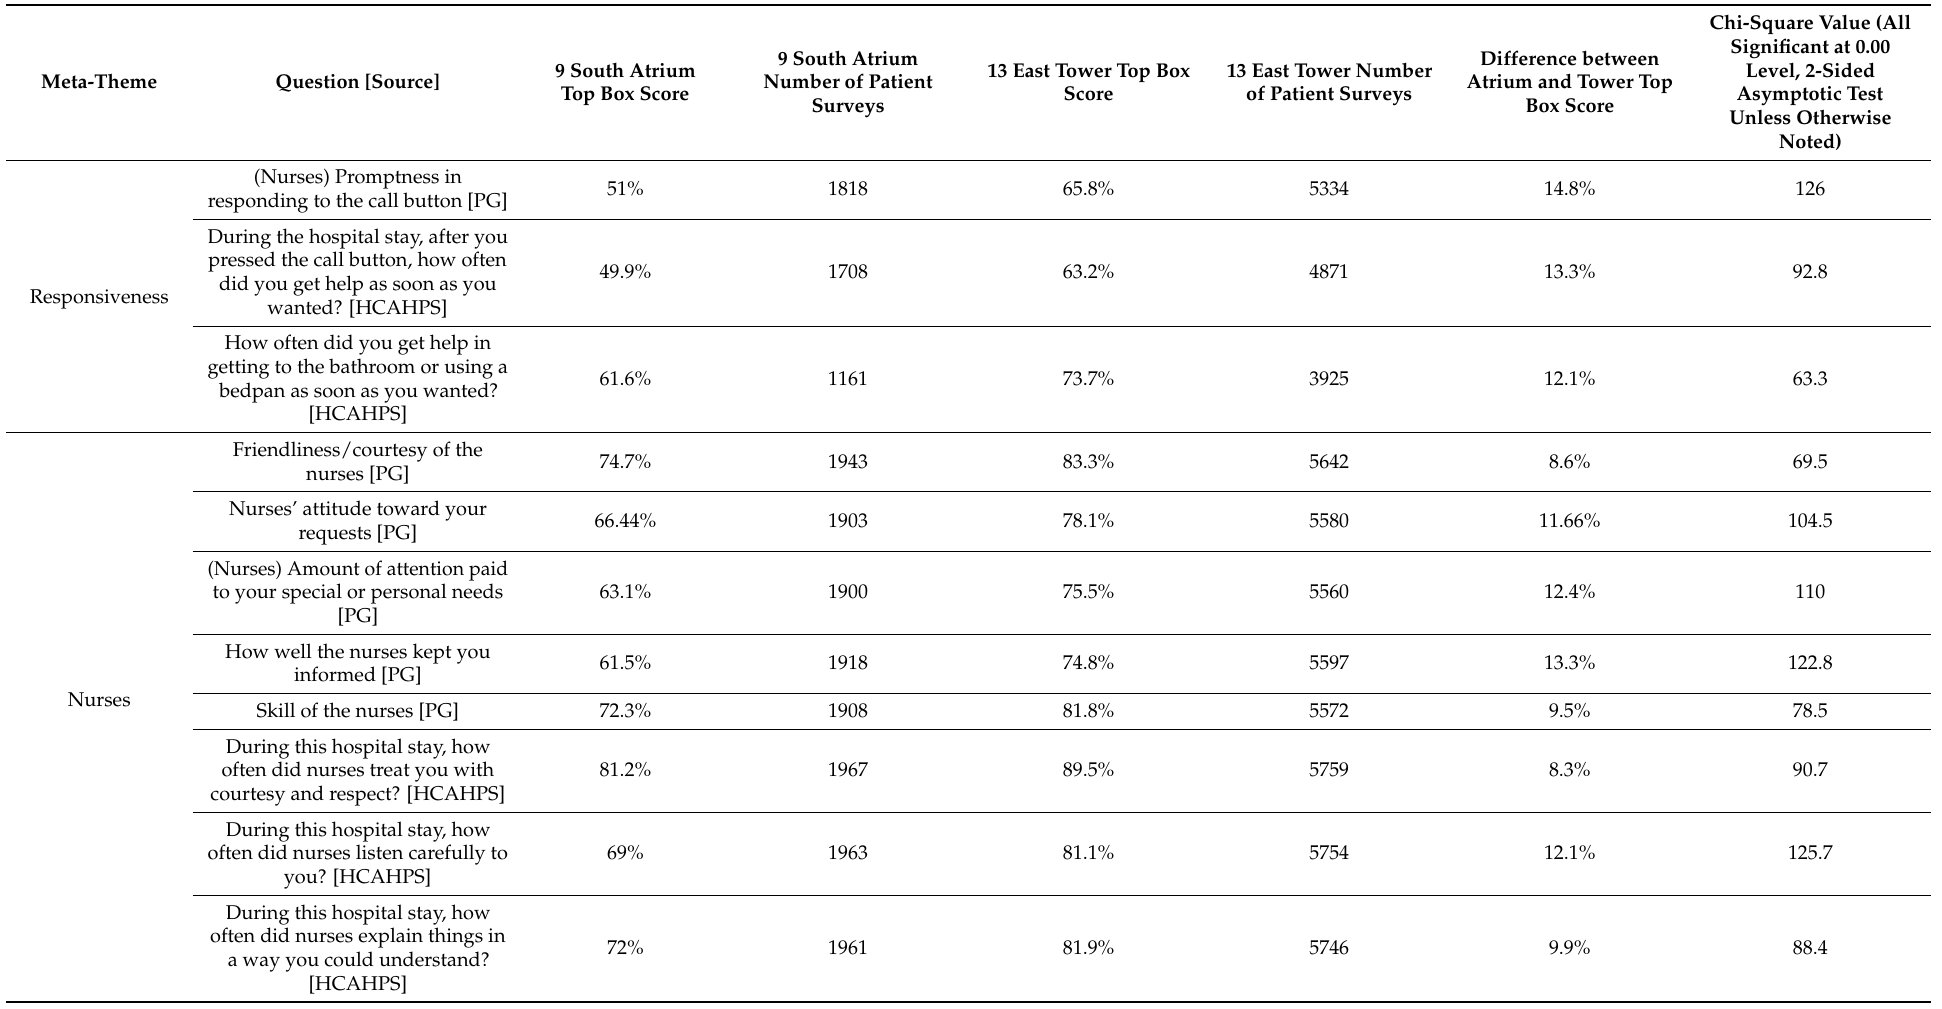
Table 1. Comprehensive list of all Press Ganey (PG) and HCAHPS questions, arranged by meta-theme along with statistical testing comparing the aggregate differences between 9 South and 13